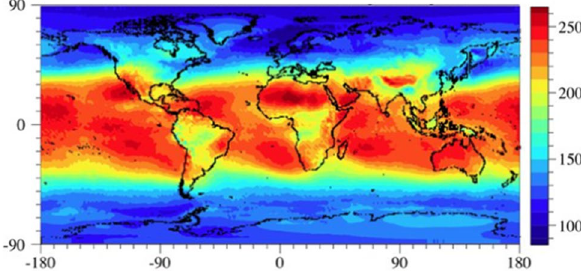
Fig. 8 Surface downward solar radiation in W/m. 2